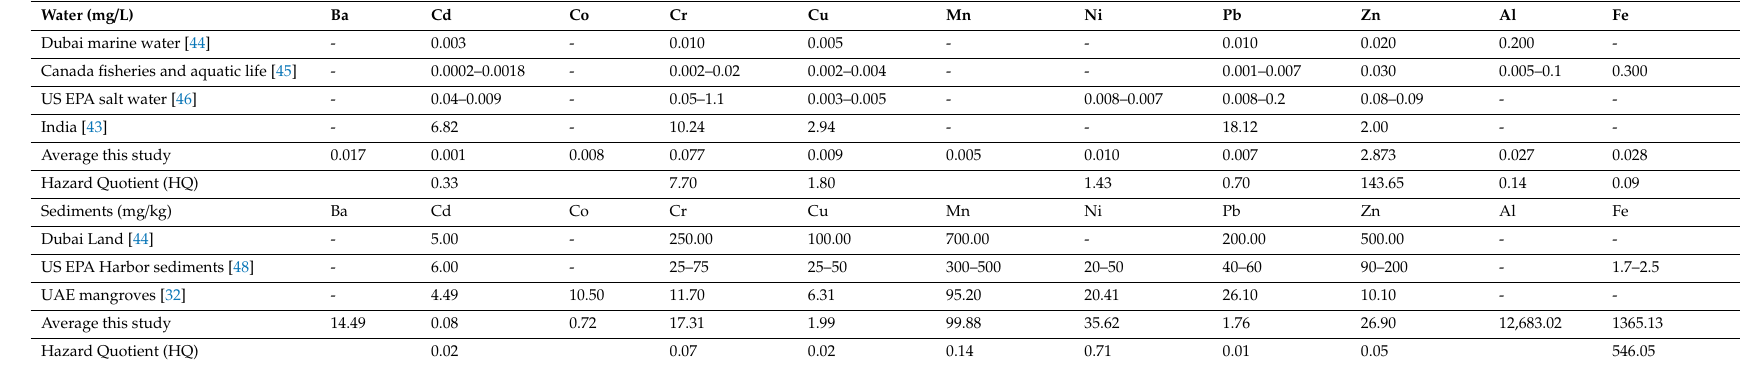
Table 3. Comparison of heavy metal concentrations in the waters and sediments of Umm Al Quwain mangroves with standard limits and other similar